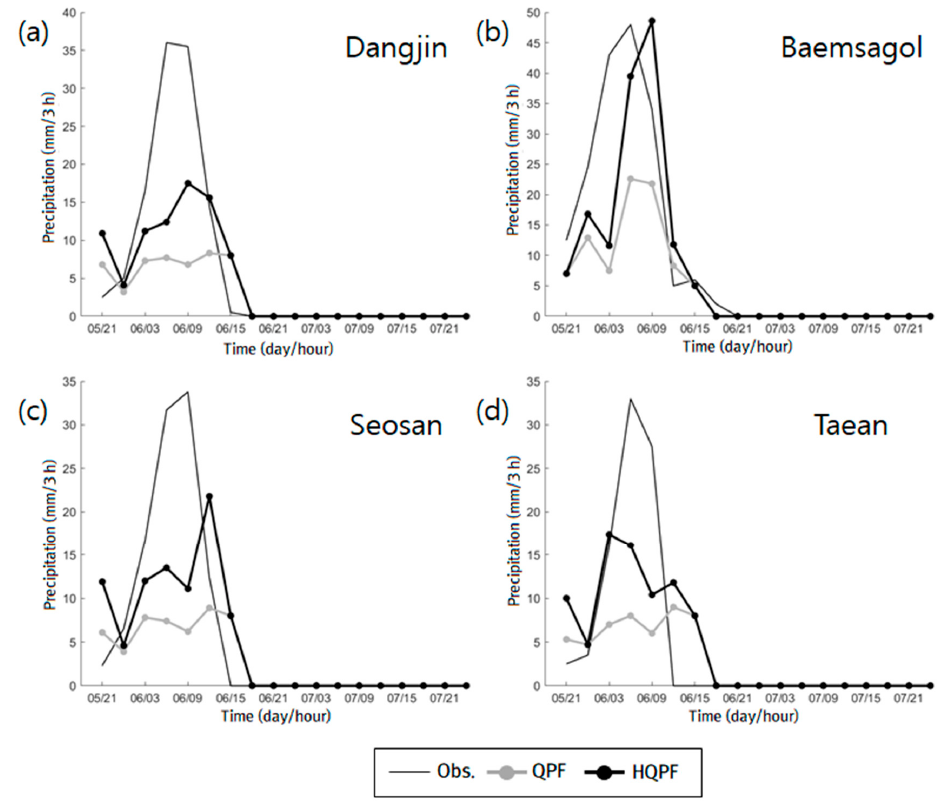
Figure 12. Time series (from 21:00 on 5 October to 21:00 on 7 October) for a 3 h accumulated precipitation at ( a ) Dangjin, ( b ) Baemsagol, ( c ) Seosan, and ( d ) Taean observational sites. Table 8. Rainfall information of the four sites from the observational data.